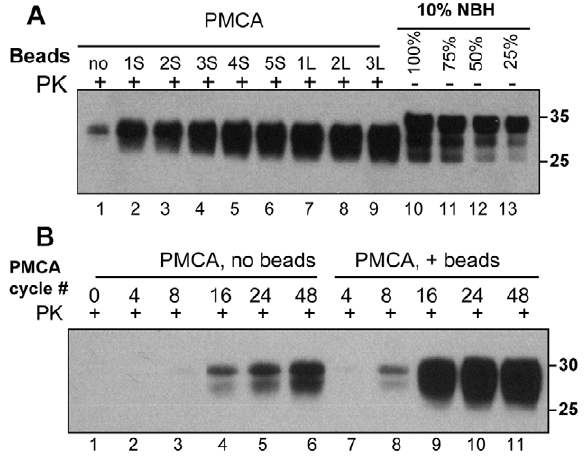
Figure 1. Beads improve the yield and rate of PrP Sc conversion. ( A ) 263K scrapie brain material was diluted 10 3 -fold into 10% normal brain homogenate (NBH) and subjected to 48 PMCA cycles in the absence of beads (lane 1) or presence of 1, 2, 3, 4 or 5 small beads (S, lanes 2–6) or 1, 2 or 3 large beads (L, lanes 7–9). 10% NBH loaded at 100%, 75%, 50% or 25% amounts were used to estimate